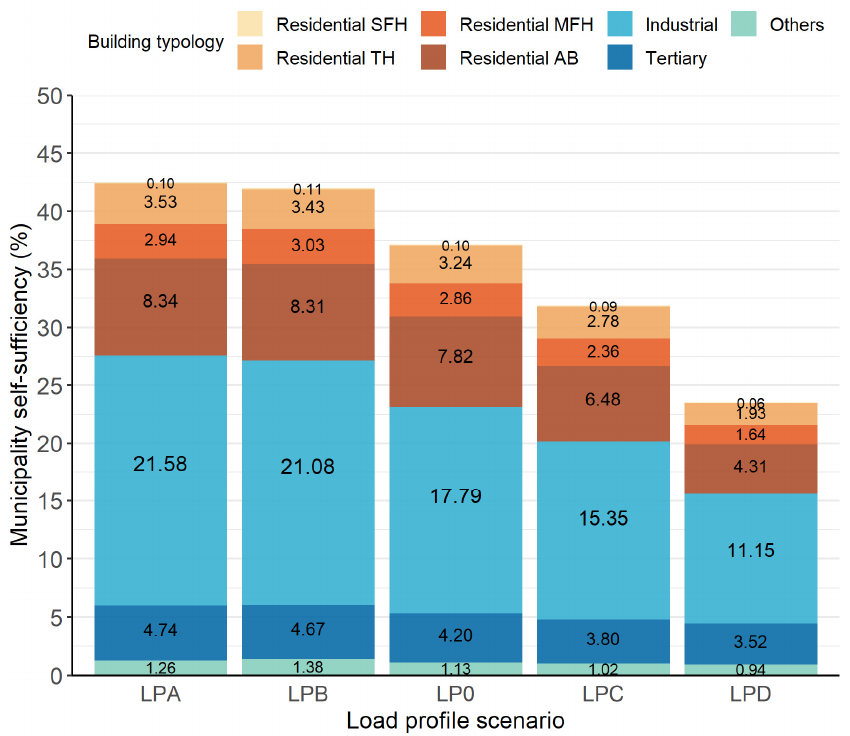
Figure 9. Contribution to the SS of the municipality of the aggregated PV production by building typology.